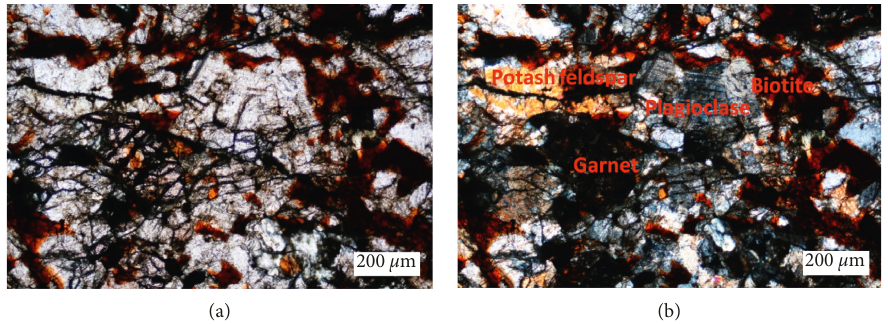
Figure 7: Results of SEM scanning in Baoguo Iron Mine. (a) Plane polarized light ( × 50) and (b) perpendicular polarized light ( ×